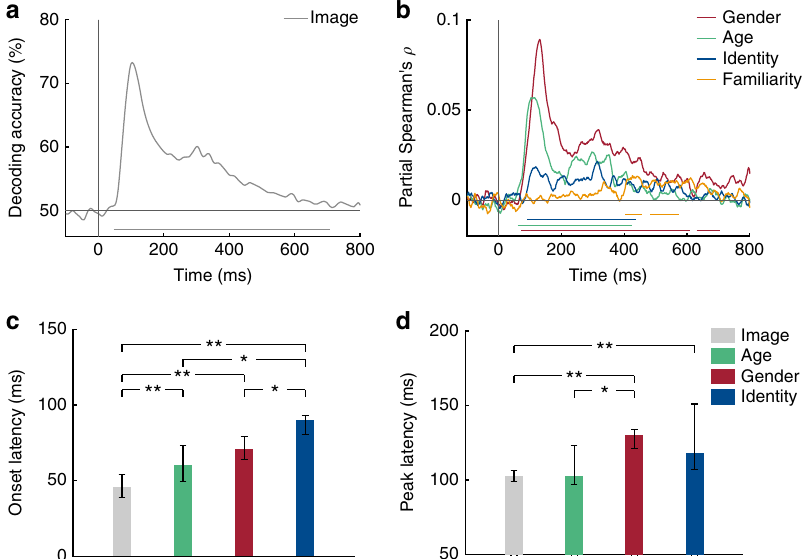
Fig. 2 Decoding of face images and dimensions from MEG signals. a Time course of image decoding where 0 indicates image onset ( n = 16). b Time course of partial Spearman correlations between MEG RDMs and model RDMs (see Fig. 1c) for gender (red), age (green), identity (blue) and familiarity (orange), partialling out all other models and low-level features (see Methods). Lines below plots indicate signi fi cant times using cluster-based sign permutation test (cluster-de fi ning threshold p < 0.05, corrected signi fi cance level p < 0.05). c, d Onset ( c ) and peak ( d ) latencies for decoding of images, gender, age and identity. Error bars indicate bootstrapped 95% con fi dence intervals. Stars above bars indicate signi fi cant differences across conditions (one-sample two- sided bootstrap test, ** p < 0.01; * p < 0.05; FDR-corrected). Source data are provided as a Source Data fi le